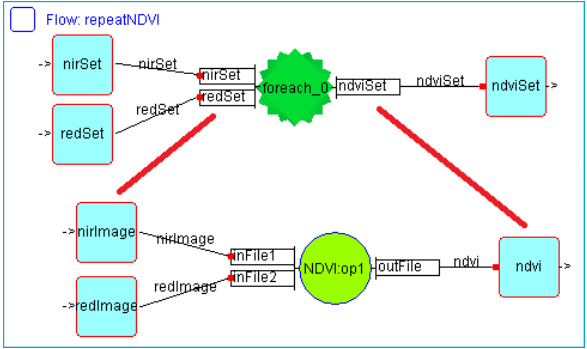
Figure 5. For-each workflow